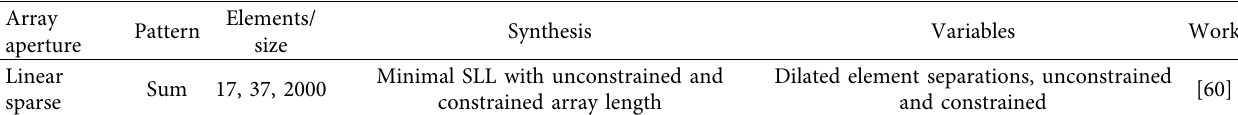
Table 6: ADT-based deterministic synthesis method: applications and features.